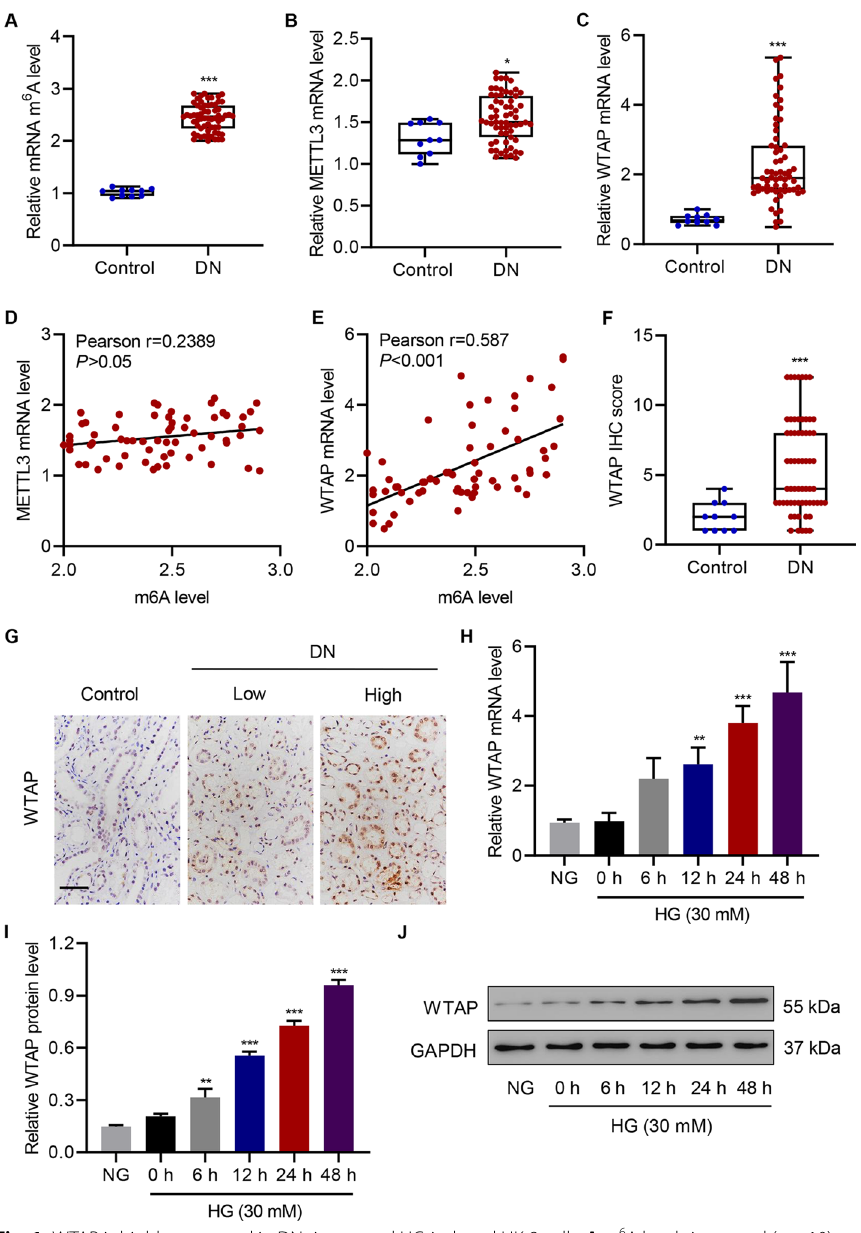
Fig. 1 WTAP is highly expressed in DN tissues and HG-induced HK-2 cells. A m 6 A levels in control ( n 10) = and DN tissues ( n 63) measured by ELISA. B , C mRNA expression of METTL3 and WTAP in the control = ( n 10) and DN tissues ( n 63) measured by real-time (RT)-qPCR. D , E Pearson correlation scatter plots = = ( n 63). F , G Protein expression of WTAP in the control ( n 10) and DN tissues ( n 63) measured by = = = immunohistochemical staining. Scale bar, 50 μm. ( H – J ) mRNA and protein expression of WTAP in NG- or HG-induced HK-2 cells measured by RT-qPCR and western blot ( n 3). Unpaired Student’s t -test was used = for the analysis between two groups, and one-way analysis of variance was used to analyze the data among multiple groups, followed by Tukey’s post hoc test. * P < 0.05, ** P < 0.01, *** P < 0.001 compared with control or 0